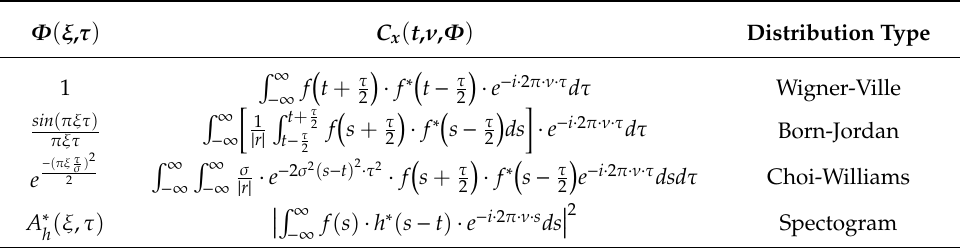
Table 2. Time-frequency representations of Cohen’s class and associated kernel functions. Φ ( ξ , τ ) C ν , Φ ) Distribution x ( t ,